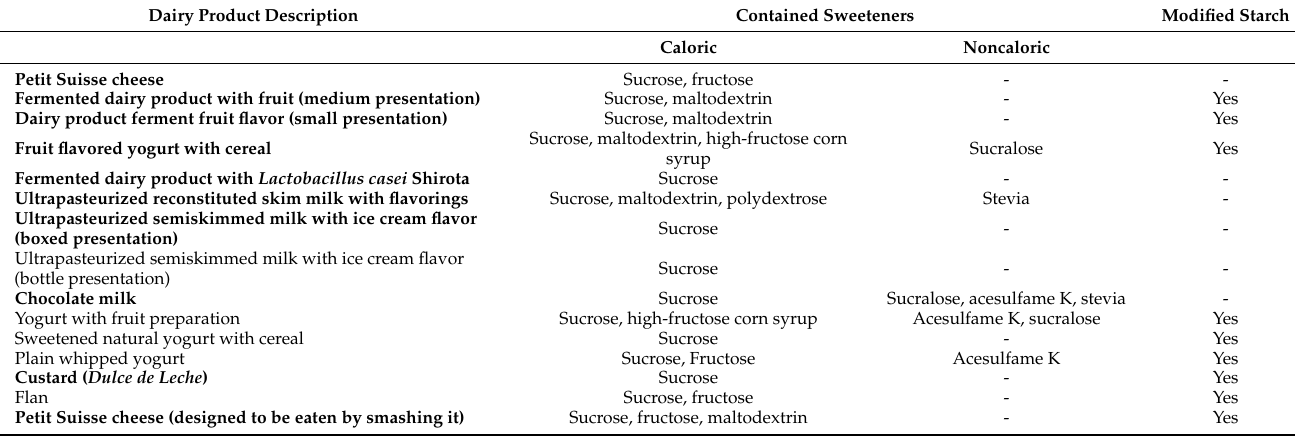
Table 2. Sweeteners contained in the dairy products selected for the